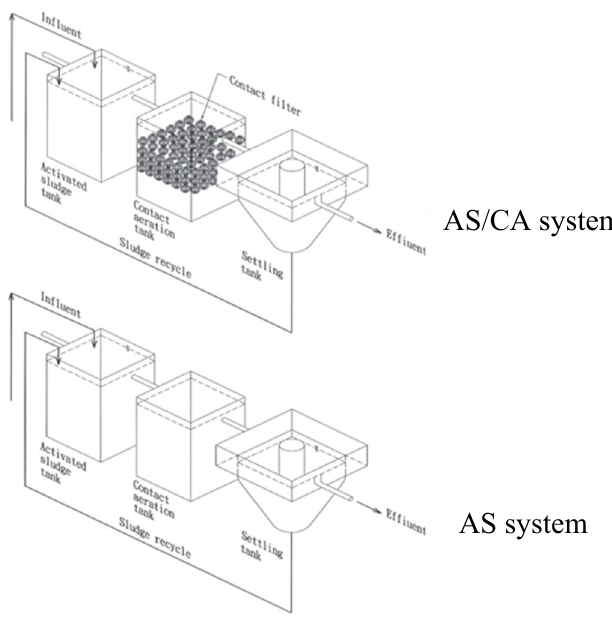
Figure 1. Flow chart of small model factory with activated sludge (AS) and activated sludge/contact aeration (AS/CA) systems.